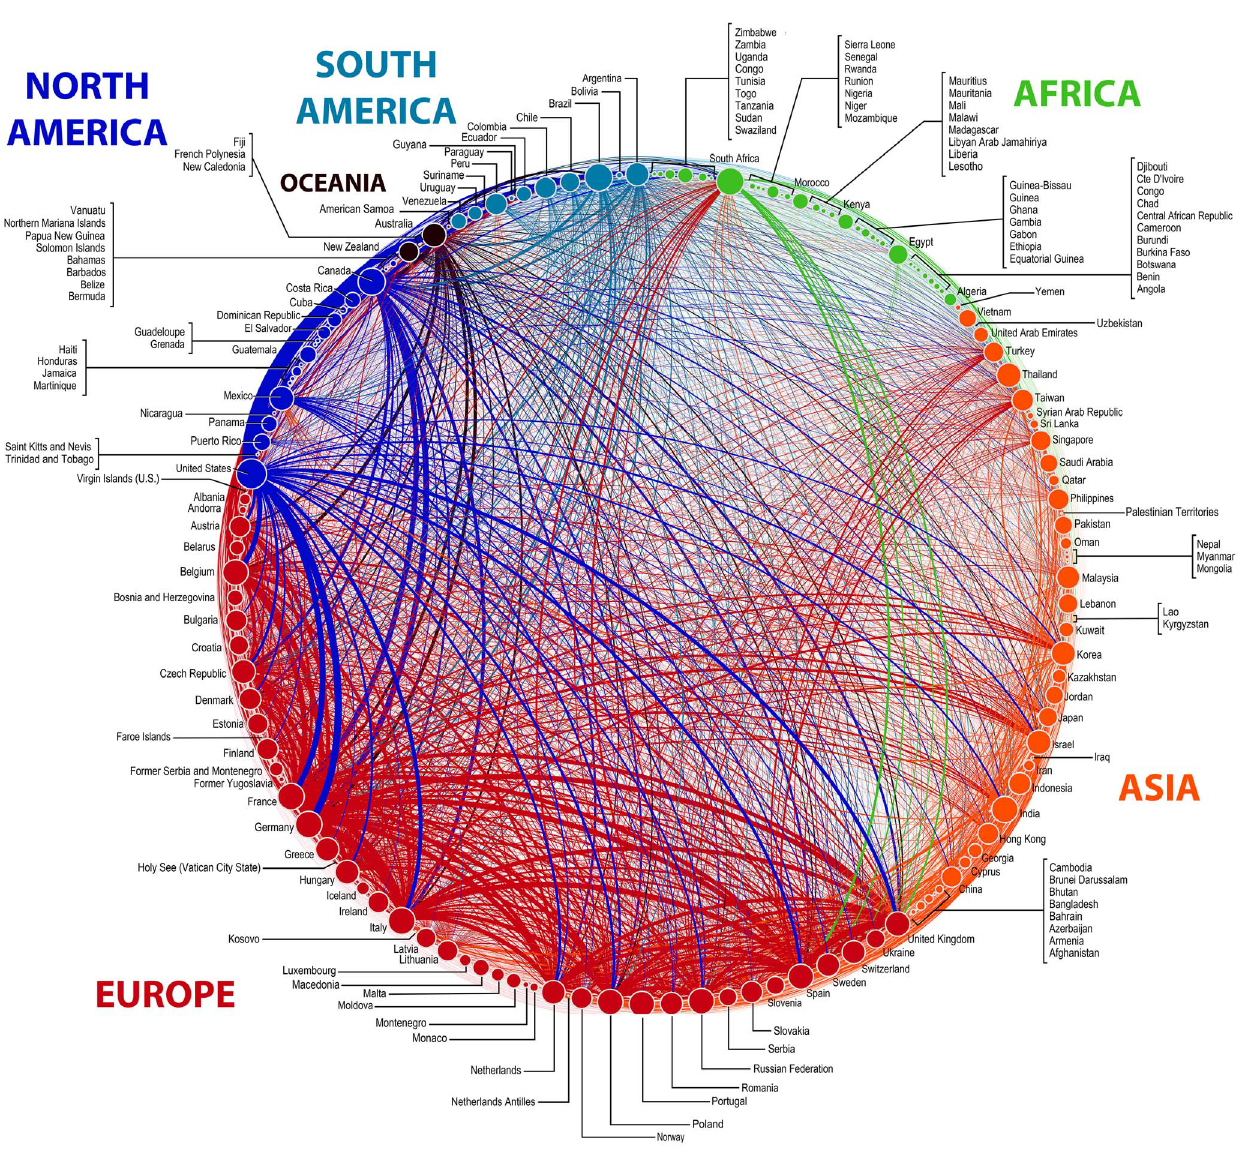
Fig. 4. Global connectivity of countries involved in multinational clinical studies. Lines represent connections between countries that reflect participation in the same study. The thickness of the lines is proportional to the total number of connections between those countries. Each dot (node) corresponds to a country that has participated in a multinational study. The size of the nodes is proportional to the total number of multinational studies. Only countries that participated in at least 1 multinational clinical trial were included in the network.